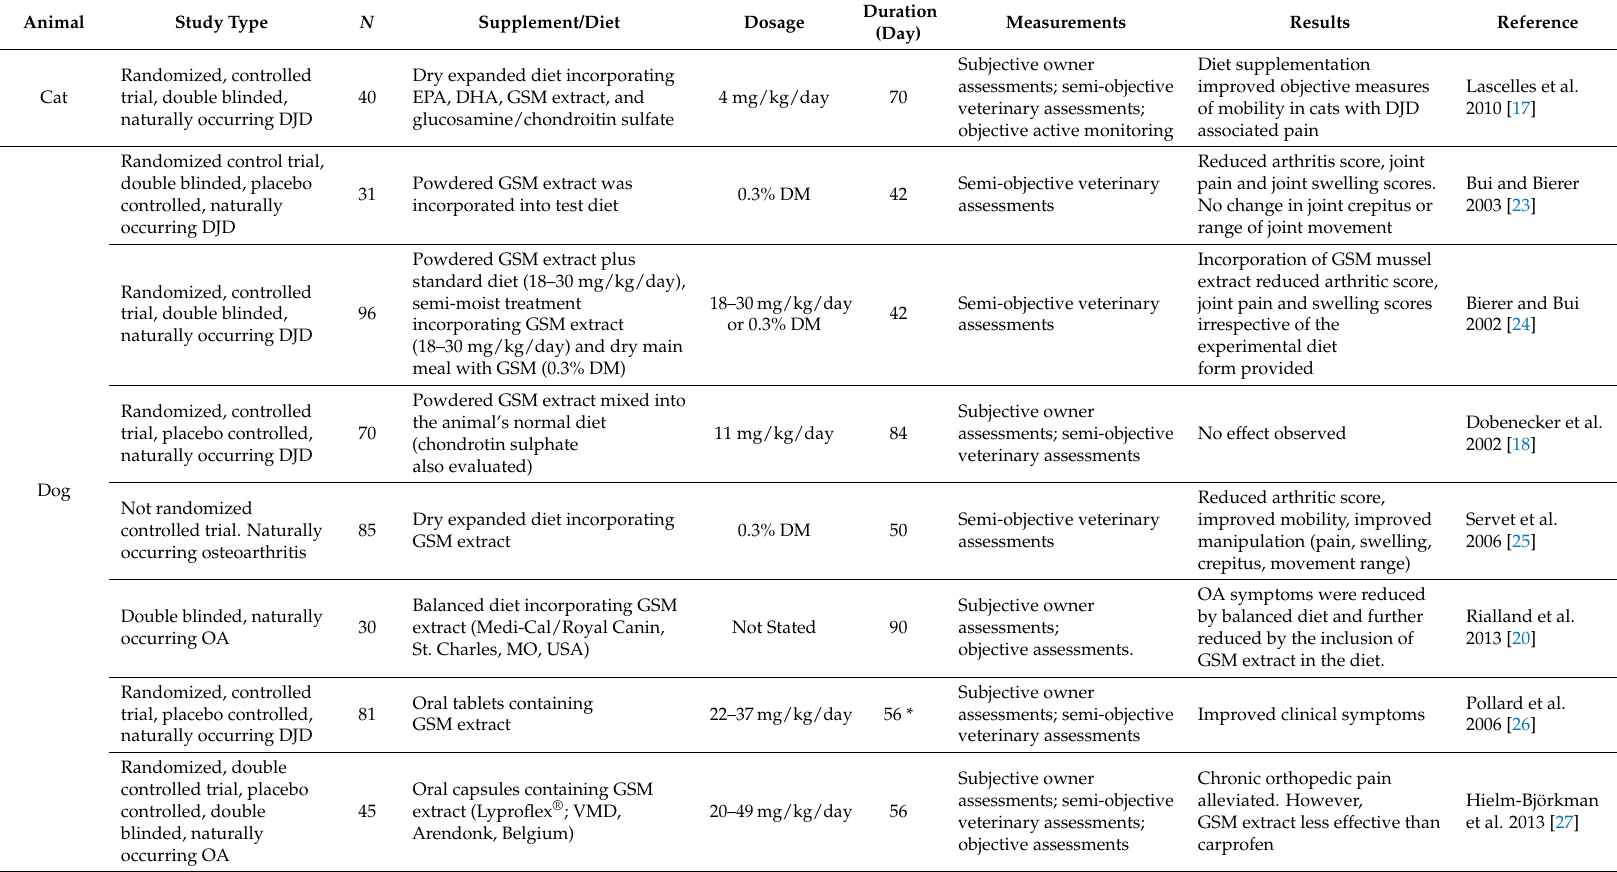
Table 1. Table summarizing studies evaluating the effects of Greenshell™ mussel (GSM; Perna canaliculus ) extracts in cats, dogs, and horses.